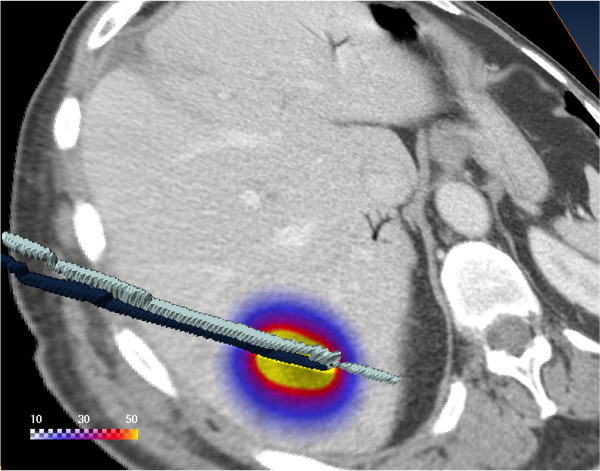
Geometry. The 3D visualization shows a CT slice with the calculated dose in Gy overlayed. The dose is applied using two catheters. The two catheters were visualized in 3D using surface rendering of the catheters labeled in the CT scan.